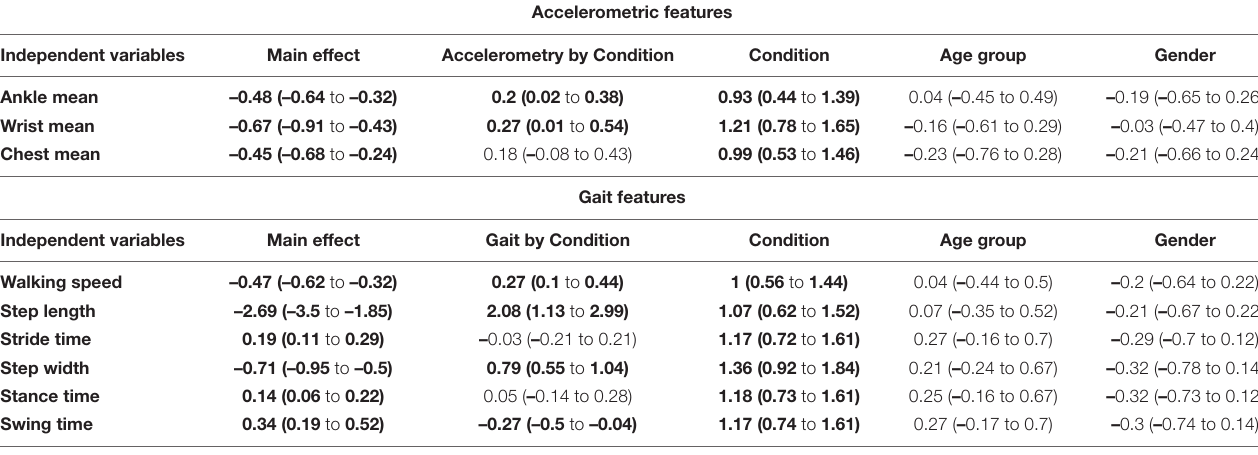
TABLE 3 | Incidence of disorientation events and accelerometric and gait features in real time.